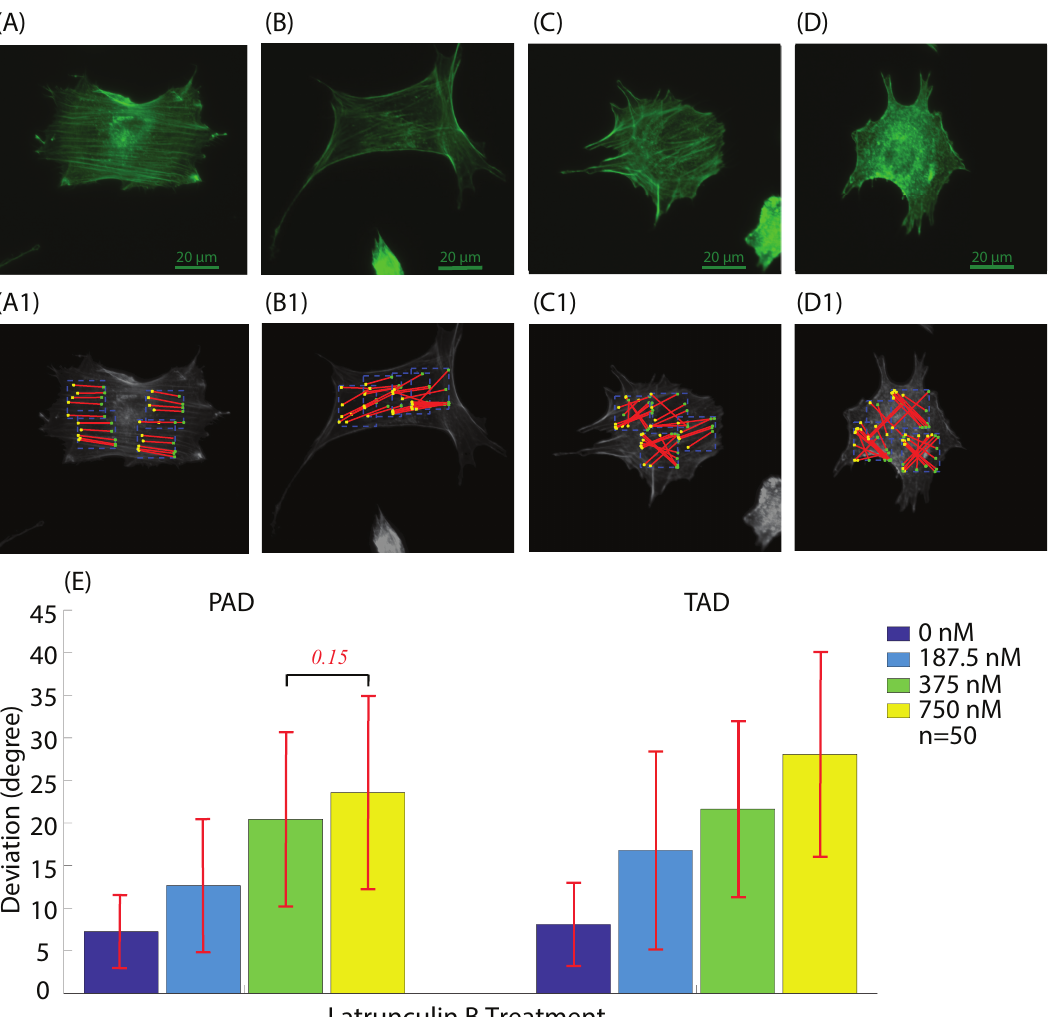
Figure 7. Example actin cytoskeleton images of cells with latrunculin B treatment concentration